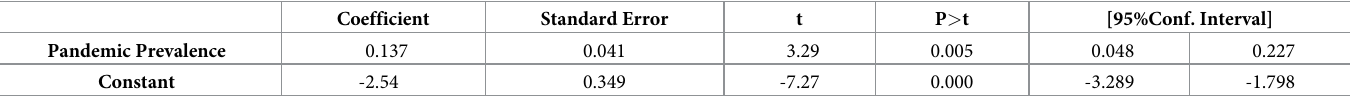
Table 6. Results of meta-regression—Excluding three trials conducted in